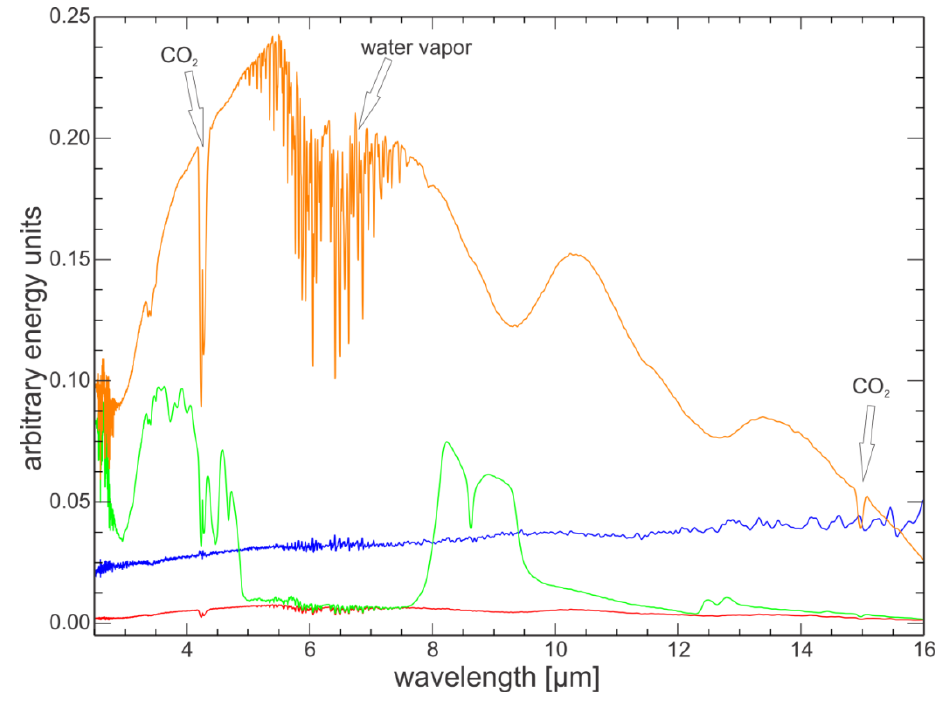
Figure 4. Example of raw energy spectra for a measurement sequence of a sample (here quartz sand with port reducer installed). In orange the gold standard energy spectrum ( V ), in green the quartz sand sample ( V ) and in red the open sample port ( V reference sample The blue line shows the fraction of incoming energy that is reflected by the sample port / V ) as a function of edge and port reducer ( V open reference